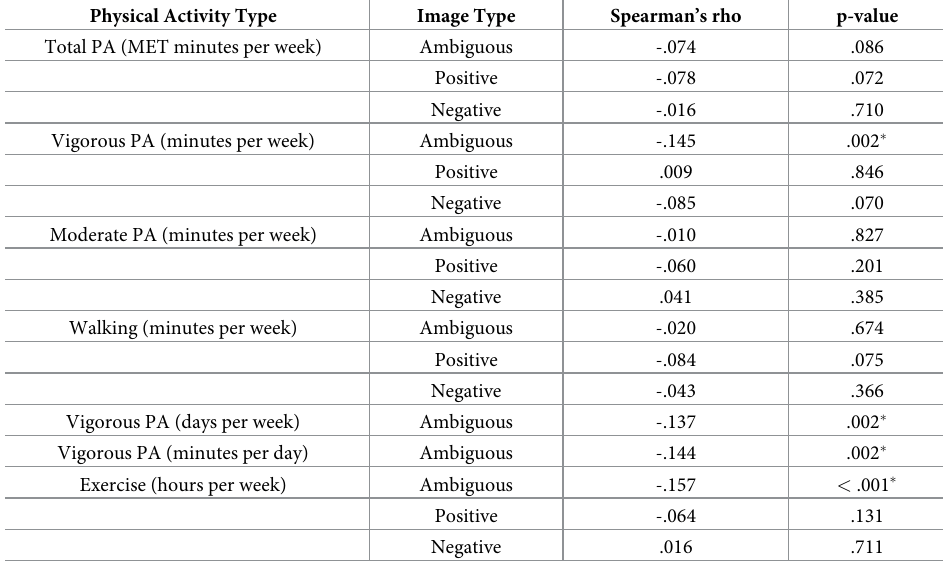
Table 2. Correlations